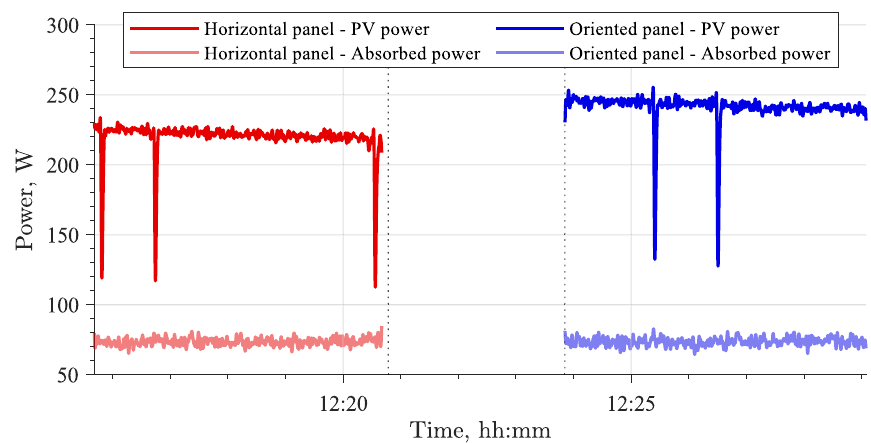
Fig. 11 Idling Agri.Q power